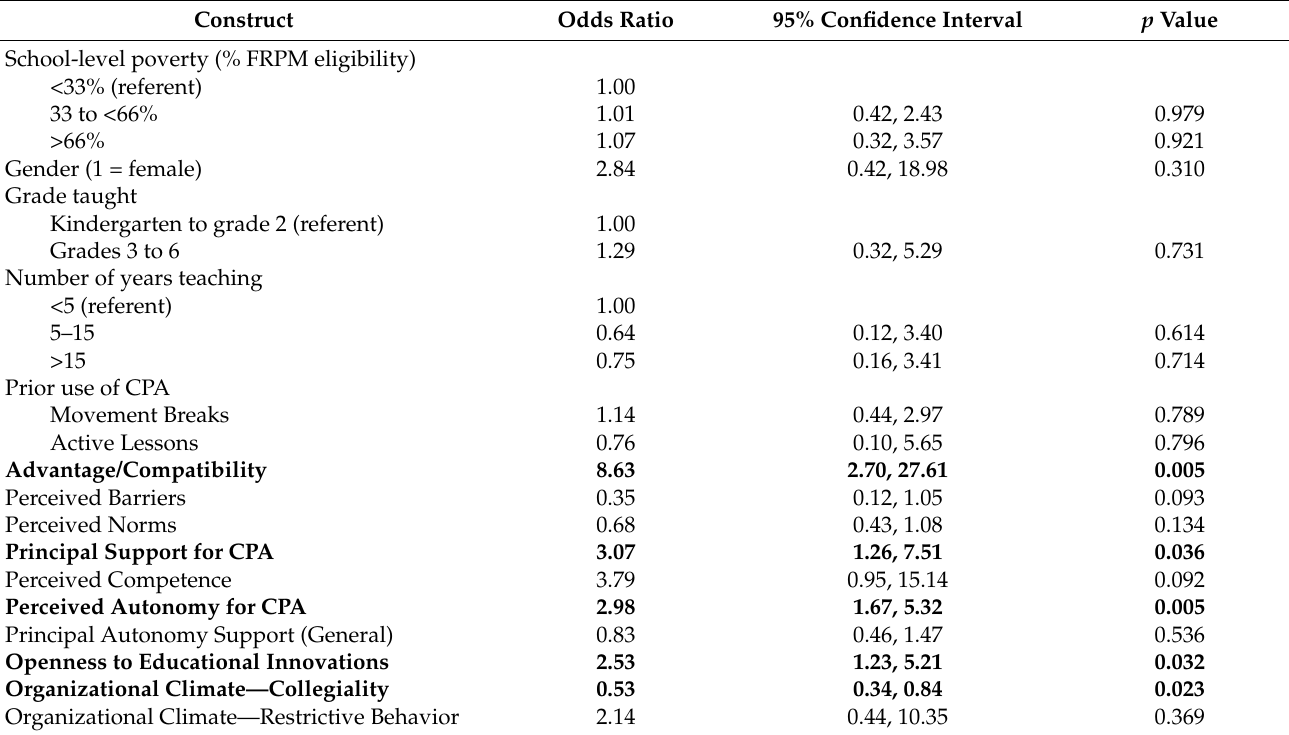
Table 5. Results of Multilevel Logistic Regression Predicting Strong Teacher Intention to Implement